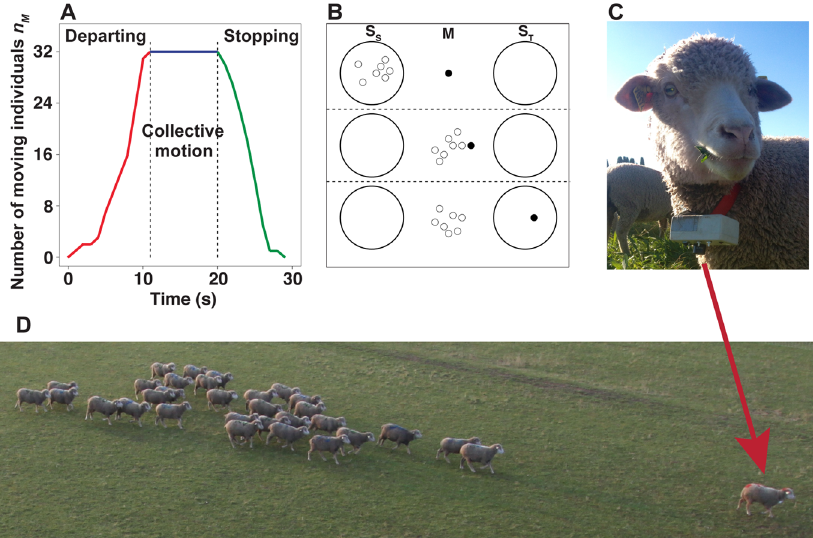
Fig 1. Experimental collective observations. (A) The number of moving individuals (n M ) as a function of time in one of the trials with 32 sheep. The departing (in red), collective motion (in blue) and stopping (in green) phases are indicated. (B) Sketch illustrating the temporal phases of an experiment. The three behavioral states of individuals are represented: (static) individuals at the starting position (S S ), moving (M), and stopped near the target (S T ). The initiator is depicted by a full circle, while open circles correspond to naive individuals. From top to bottom, we observe the first transition S S ! M, the collective motion phase, and the first transition M ! S T . (C) shows one of the trained individual fitted with the vibrating collar. (D) A snapshot of a herd of 32 sheep in collective motion provoked by the departure of the trained